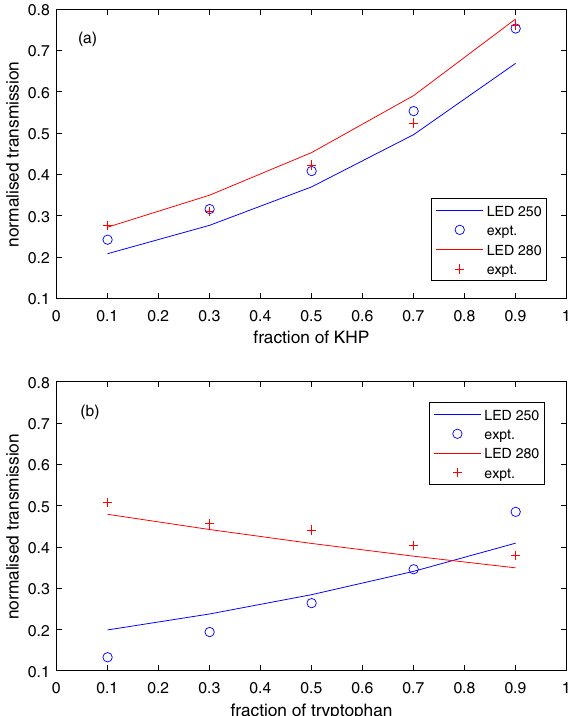
Figure 4. Transmittance data (symbols) and model (lines) for two mixtures of contaminants in water, with total concentration 10 mg/L and using 250 nm (blue) and 280 nm (red) LEDs. The mixtures are ( a ) KHP and clothianidin, and ( b ) tryptophan and